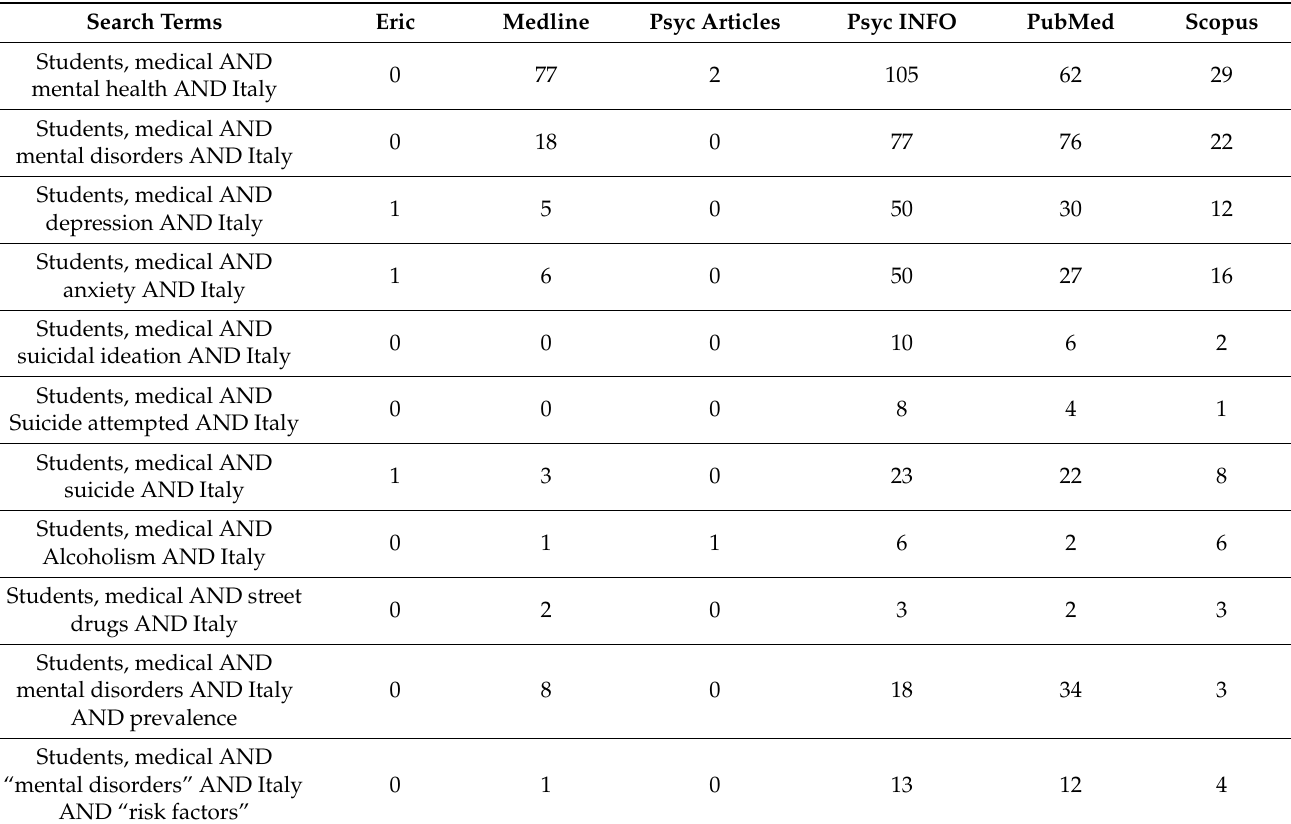
Table 1. Selection of the studies on mental health problems among Italian medical